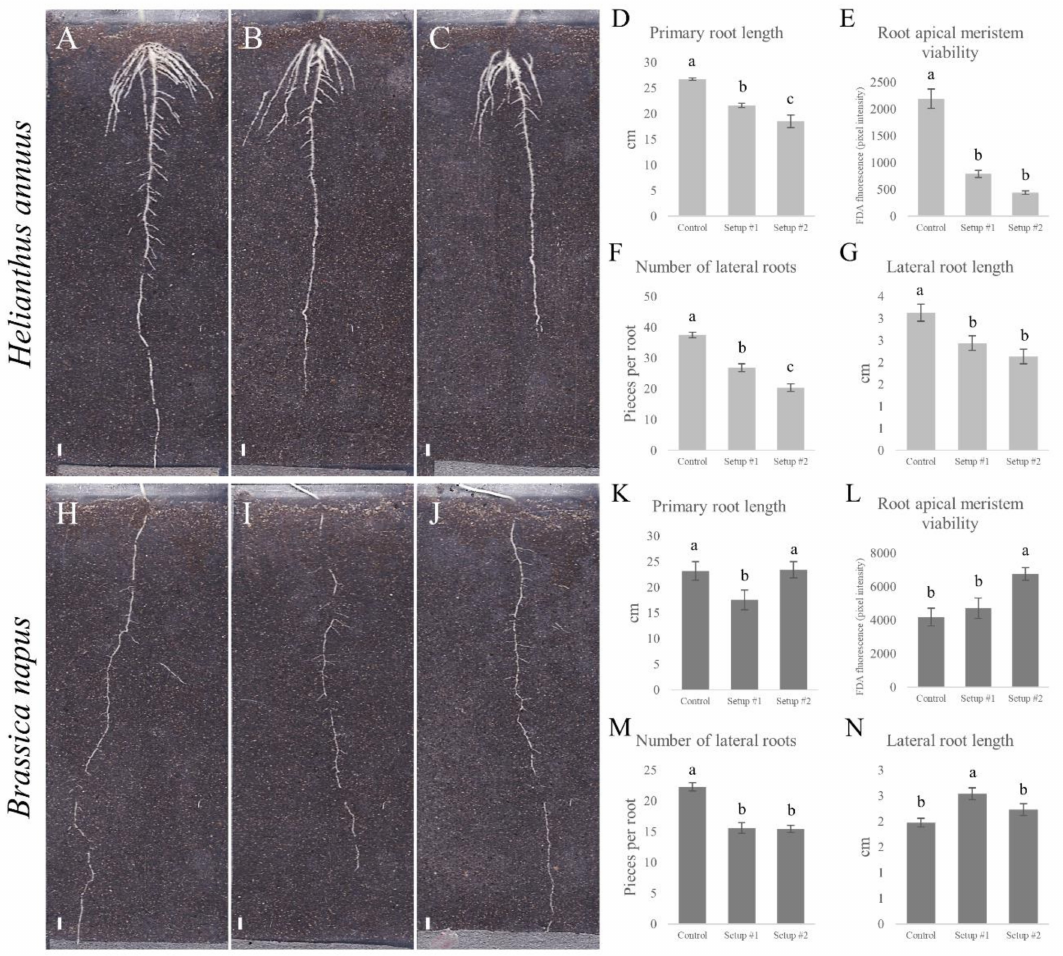
Figure 4. ( A – C ), ( H – J ) Representative images of the e ff ect of model sewage on the root system architecture of 6-day-old H. annuus and 10-day-old B. napus . (( A / H ): control, ( B / I ): Setup #1, and ( C / J ): Setup #2; bar = 1 cm). Length of the primary root (( D ) sunflower, ( K ) rapeseed); viability of the root apical meristem (( E ) sunflower, ( L ) rapeseed); and number (( F ) sunflower, ( M ) rapeseed) and length of lateral roots (( G ) sunflower, ( N ) rapeseed). Di ff erent letters indicate significant di ff erences according to Duncan-test ( p <